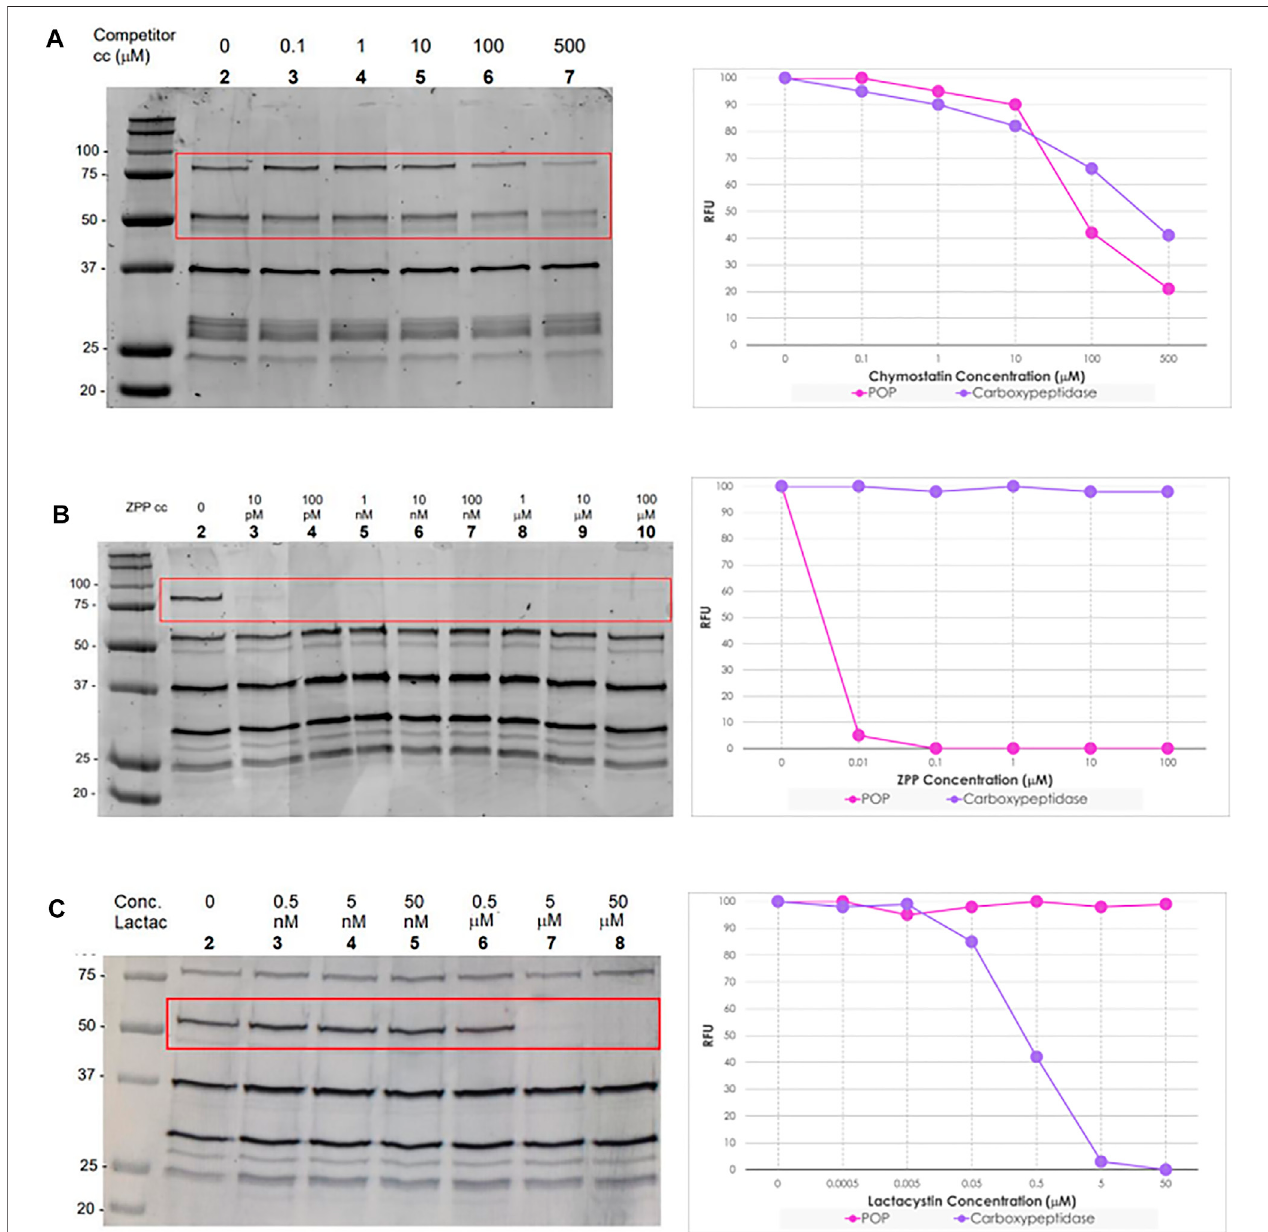
FIGURE 5 | Left: In-gel fl uorescence analysis (emission at 560 nm) of the competitive ABPP between increasing concentration of serine protease inhibitors and TAMRA-FP(1 μ M)in L.mexicana promastigoteslysates(1 mg/ml). Right: Relative fl uorescenceunits(RFU)vs.competitorconcentrationinhibitioncurvesofbandsPOP (80 kDa)andCarboxypeptidase(60 kDa).Indetails, Gel(A) Chymostatin(0 – 500 μ M); Gel(B) ZPP(0 – 100 μ M);and Gel(C) Lactacystin(0 – 50 μ M).Forexperimentsand analysis performed in L. mexicana amastigote lysates, Supplementary Figure S9 .